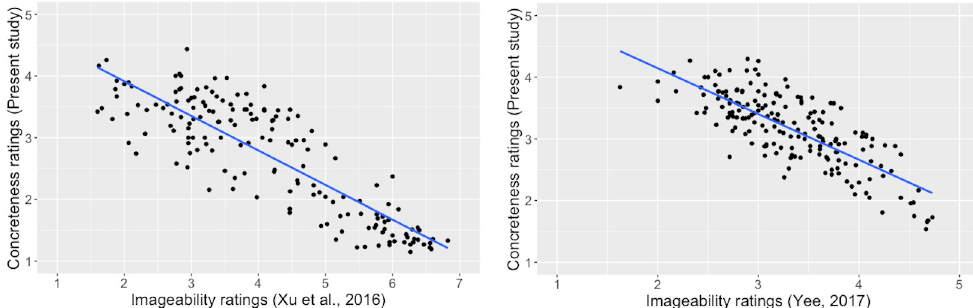
Fig 6. a. Correlation of the present concreteness ratings and imageability ratings by [34], r = -.85, p < .0001. (in [34], “1” represented “not imageable”, and “7” represented “highly imageable”; in the present study, “1” represented “very concrete”, and “5” represented “very abstract”.). b. Correlation of the present concreteness ratings and imageability ratings by Yee [32], r = -.77, p < .0001. (in Yee [32], “1” represented “difficult to form an image”, and “5” represented “easy to form an image”; in the present study, “1” represented “very concrete”, and “5” represented “very abstract”.).